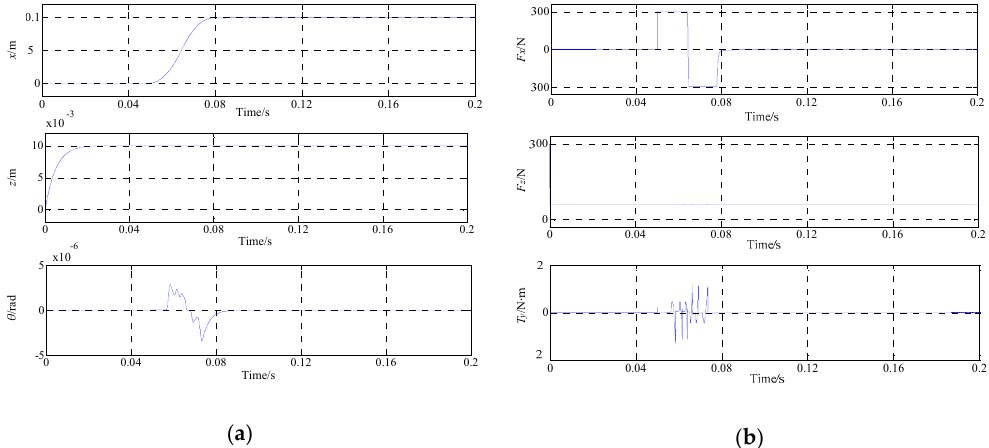
Figure 13. Three degrees-of-freedom (DOF) position close-loop simulation result: ( a ) position and angle; ( b ) electromagnetic force and torque.